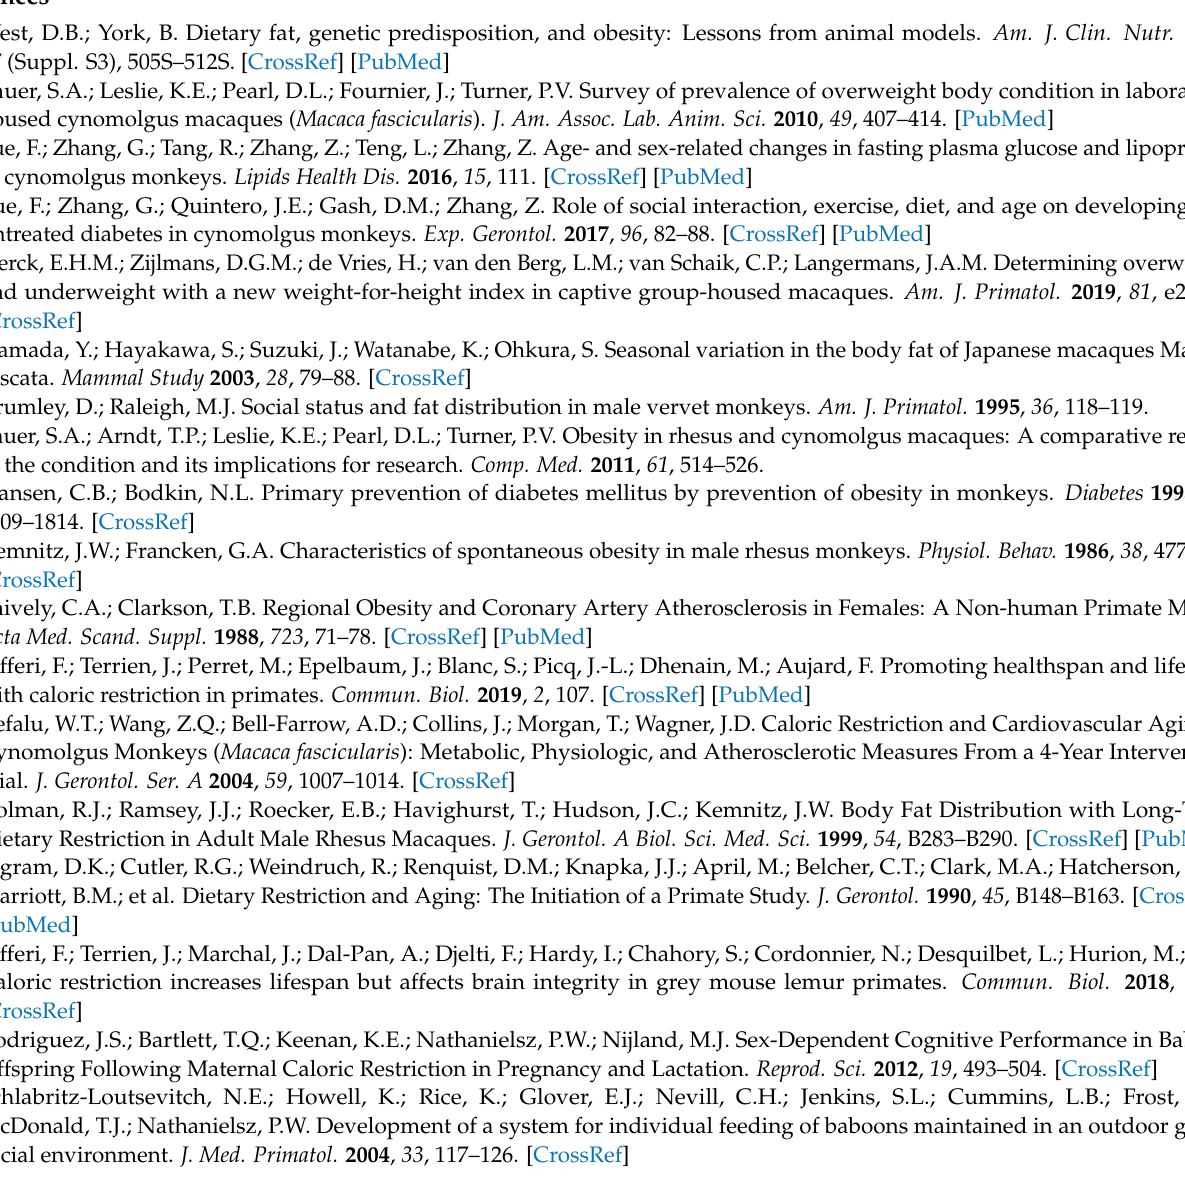
Table A1. Health record examination of individuals with severe weight loss one year before and after caloric restriction (CR). Case Period Age/Sex/Rank Medical Condition 1 Before CR 12, M, high Diabetes mellitus and diarrhea 2 Before CR 20, F, low Diabetes mellitus 3 Before CR 12, F, high Diarrhea 4 After CR 17, F, middle Diabetes mellitus 5 After CR 13, F, high Diarrhea 6 After CR 20, F, middle 7 After CR 22, F, low Diarrhea 8 After CR 11, F, middle Diarrhea 9 After CR 19, F, middle Diabetes mellitus 10 After CR 24, F,